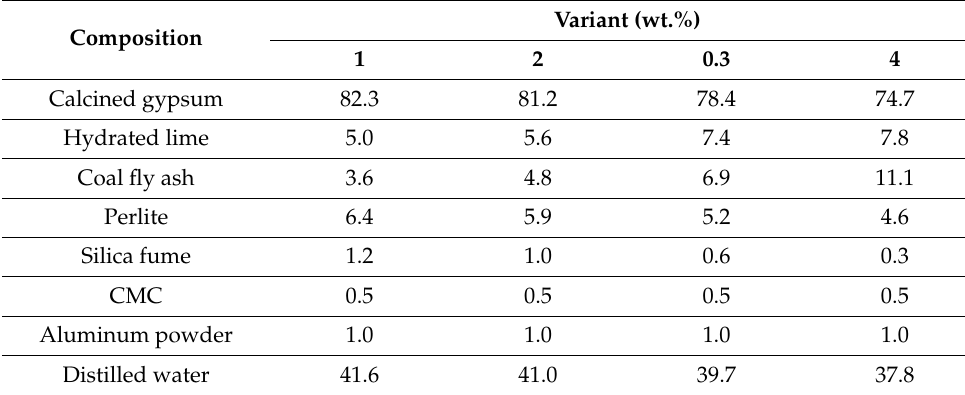
Table 2. The experimental